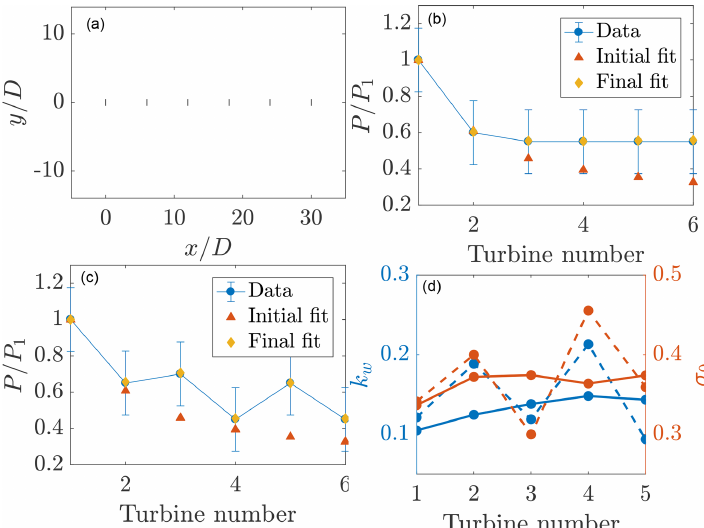
Figure A1. (a) Model problem setup. (b, c) The EnKF model fits for the model problem with two prescribed, artificial mean power profiles and Gaussian random noise. (d) Model parameters shown with solid (b) and dashed (c) lines. The wake model parameters for the last turbine downwind are not shown since they do not impact the state estimation